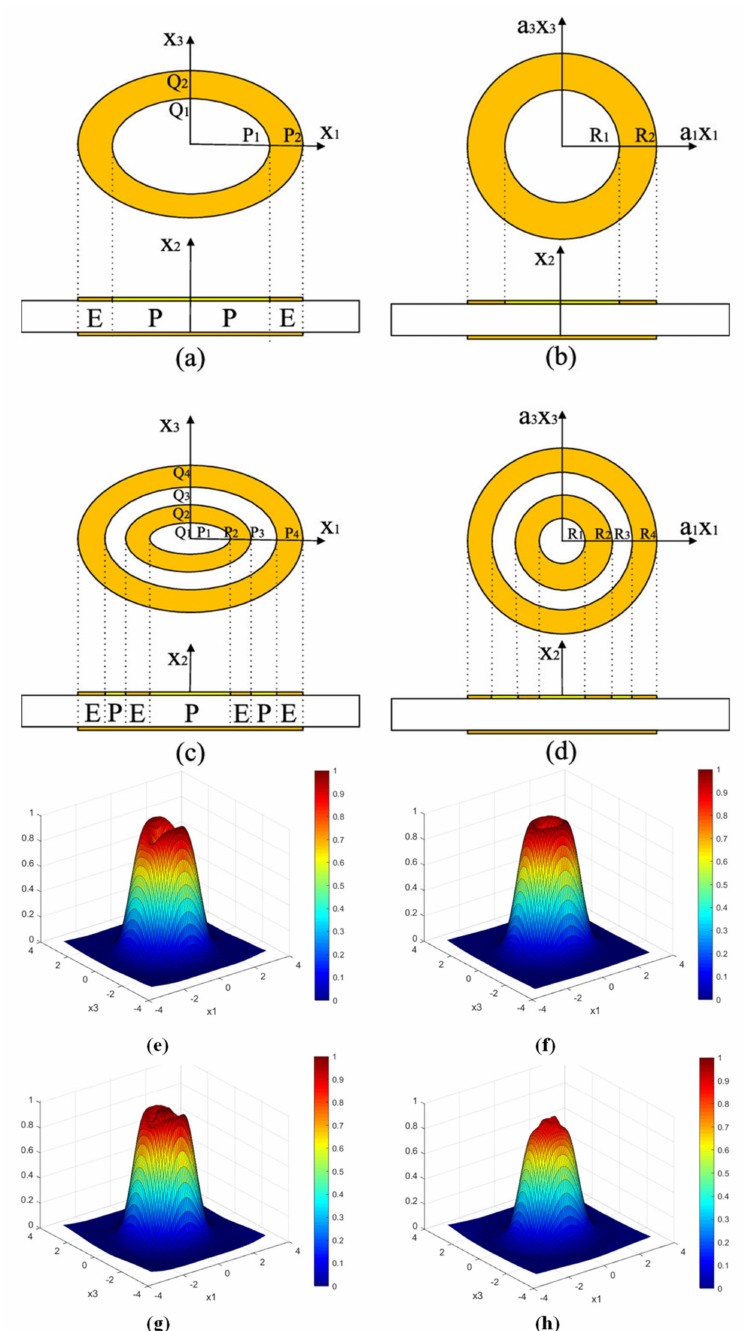
Figure 5. Structure of QCM with ( a ) elliptical single ring, ( b ) circular ring, ( c ) elliptical double ring, and ( d ) circular double ring electrodes. R 1 , R 2 , R 3 , and R 4 are the radii of each circular electrode, respectively, and P 1 , P 2 , P 3 , and P 4 are the major semi-axes of each elliptical electrode, respectively. Q 1 , Q 2 , Q 3 , and Q 4 are the short semi-axes of each elliptical electrode, respectively. Surface displace- ment distribution of ( e ) circular single-ring electrode QCM, ( f ) elliptical single-ring electrode QCM, ( g ) circular double-ring electrode QCM, and ( h ) elliptical double-ring electrode QCM